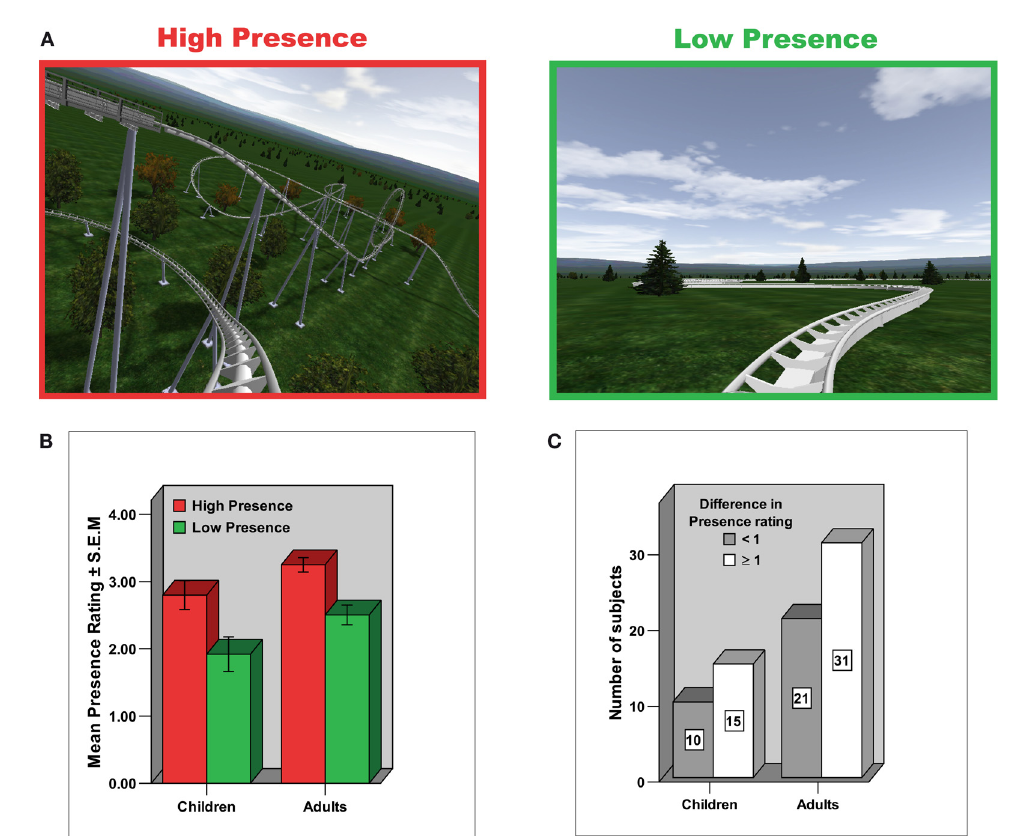
Figure 1 | Experimental design and Presence rating. (A) Experimental paradigm. Different roller coaster scenarios were presented by means of MR- compatible goggles and earphones. Whereas in the High Presence condition the roller coaster ride consisted of spectacular ascending and descending sections and loops, in the Low Presence condition the roller coaster cart followed a winding but horizontal path. (B) Depicted is the mean ± S.E.M. in Presence rating on a 5-point scale, broken down for group (adults/children) and condition (High Presence/Low Presence). The scale measures the subjective impression of how much the subjects felt they were situated in the midst of the action of the roller coaster ride rather than merely observing it. Both adults and children clearly indicated an enhanced presence experience in the High compared to the Low Presence condition. (C) Similar distribution of presence ratings in adults and children, indicat- ing that about 40% of subjects in each group reported a difference in presence rating of less than one between the High and Low Presence condition (referred to in the paper as low Presence rating group), whereas about 60% of subjects in each group reported a difference in the presence rating of higher than or equal to one (referred to as high Presence rating